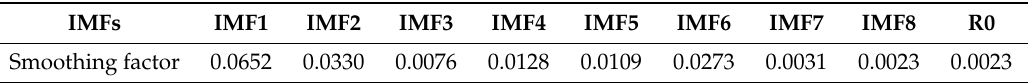
Table 1. The values of the smoothing factor for each FOA-GRNN trained by the IMFs and R0. IMFs IMF1 IMF2 IMF3 IMF4 IMF5 IMF6 IMF7 IMF8 R0 Smoothing